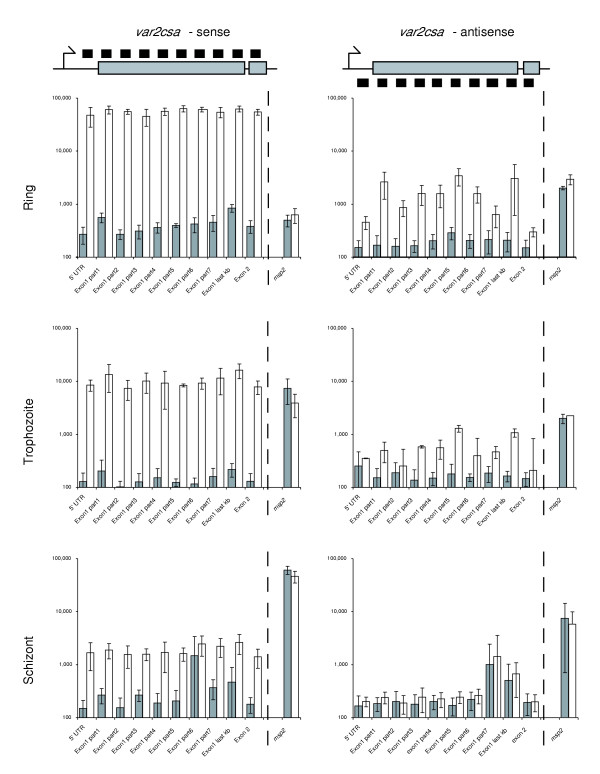
Consistent sense transcript and interspersed antisense transcript in var2csa gene. Histograms showing apparent absolute abundance of both sense and antisense transcript at the var2csa locus in CD36 (grey) and CSA (white) panned parasites. Different columns show the apparent absolute abundance for oligonucleotides at individual positions along the whole var2csa gene. Left panels show probes corresponding to sense transcript, right panels show probes corresponding to antisense transcripts. Separate histograms show data for ring, trophozoite and schizont stages. Standard deviation is shown. No truncated 5' transcript of the var2csa gene is apparent in CD36 panned parasites, suggesting regulation is not controlled by premature termination of transcription. In ring stages, where var2csa transcript is most abundant in CSA parasites, apparent absolute abundance is also increased for antisense transcripts throughout the gene. Unlike sense transcription, apparent absolute abundance for all antisense transcripts varies greatly between adjacent probes, perhaps indicative of multiple short antisense transcripts initiating throughout the locus. Abundance of sense and antisense transcript in both populations is also shown for a non-var locus, msp2, for which high antisense transcription has previously been measured [34]. Both steady-state sense and antisense levels for the var2csa locus are comparable with those found at the msp2 locus.